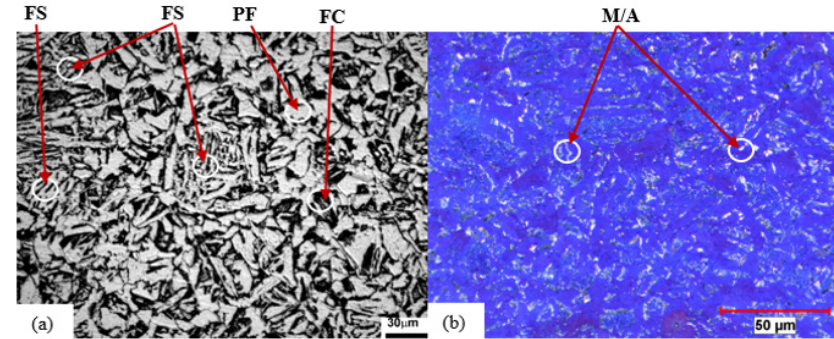
Figure 7: Optical microstructure characterization of CGHAZ for T-SAW. (a) 2% Nital etching and (b) Klemm I